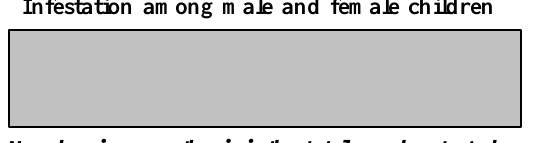
Number in parenthesis is the total number